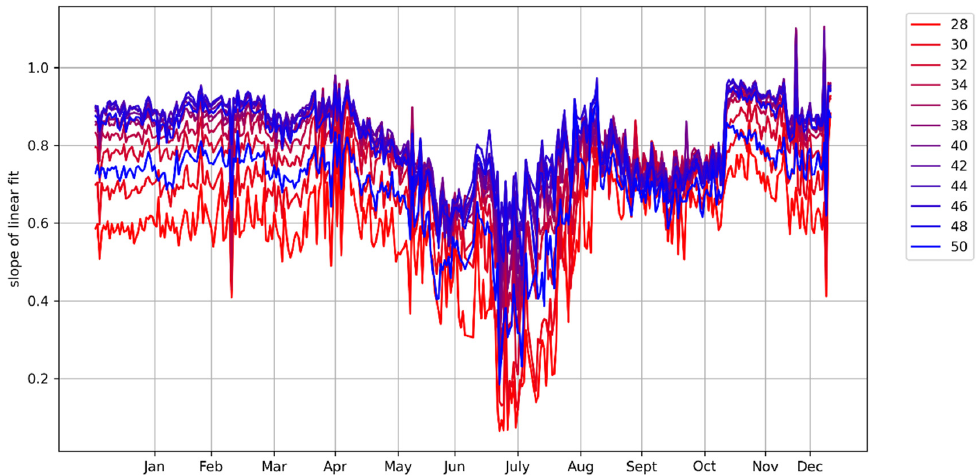
Figure 2. Daily slopes in the linear ice model in the Arctic per incidence angle in the year 2019 (a 2° incidence interval is used for a clearer look).